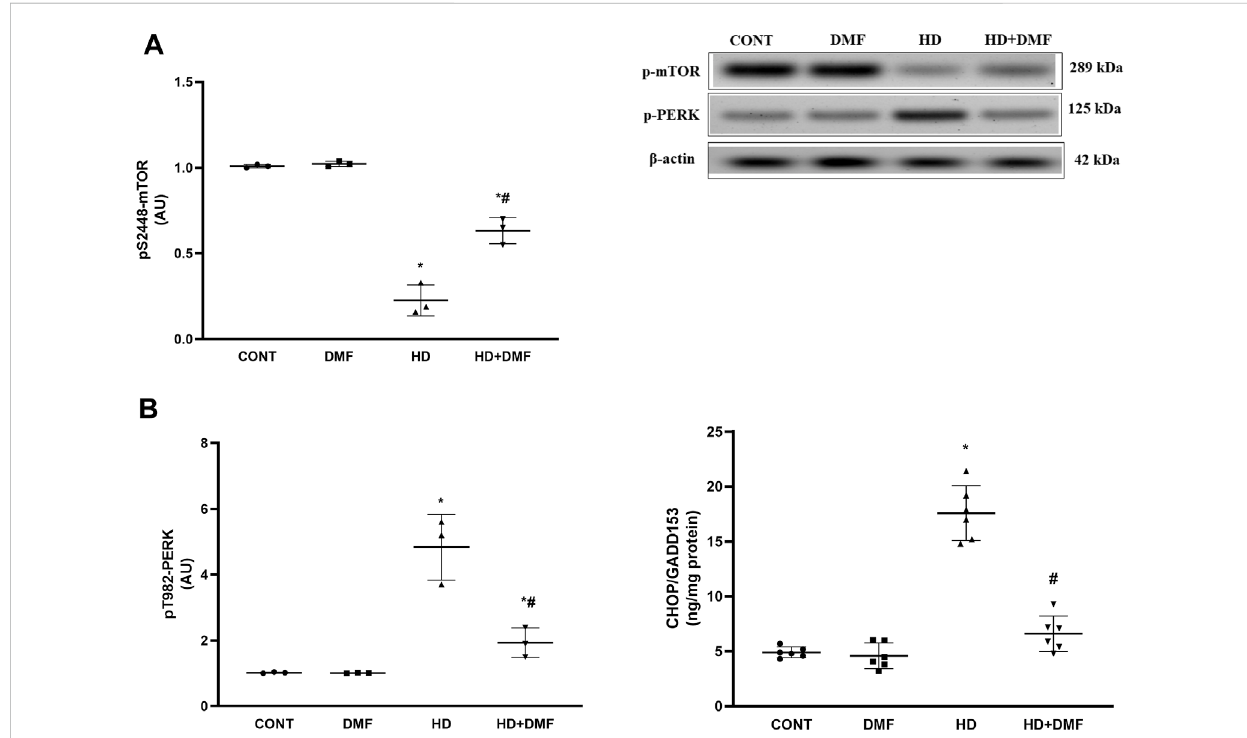
Effect of DMF on the striatal protein expression/content of (A) p-mTOR, (B) p-PERK, and CHOP/GADD153 in HD rats. Data are represented as mean±SD( n =3rats/group forWB; n =6rats/groupfor ELISA) usingone-way ANOVA, followedbyTukey ’ s posthoc test;*vs.CONT and#vs.HDat p < 0.05. CHOP/GADD153, C/EBP homologous protein; CONT, control; DMF, dimethyl fumarate; HD, Huntington ’ s disease; mTOR, mammalian target of rapamycin; PERK, protein kinase R-like endoplasmic reticulum